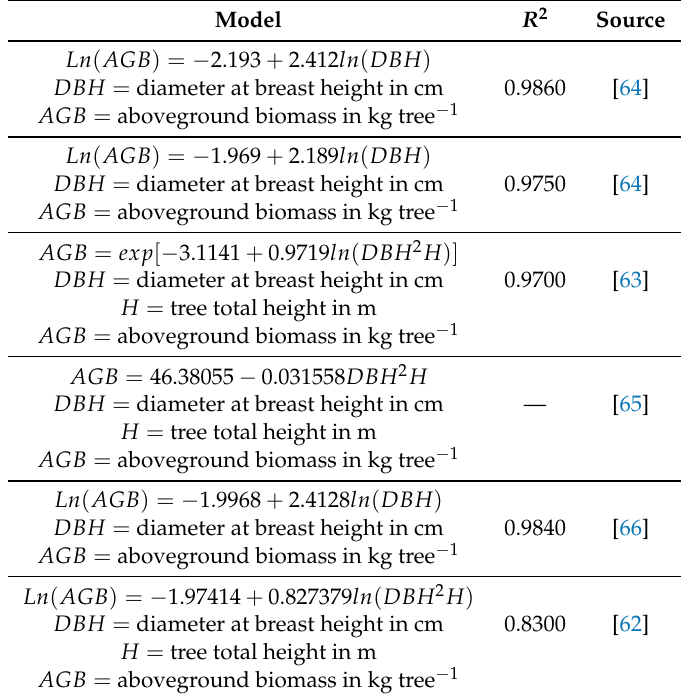
Table 2. Allometric models used in the present study for the estimation of aboveground